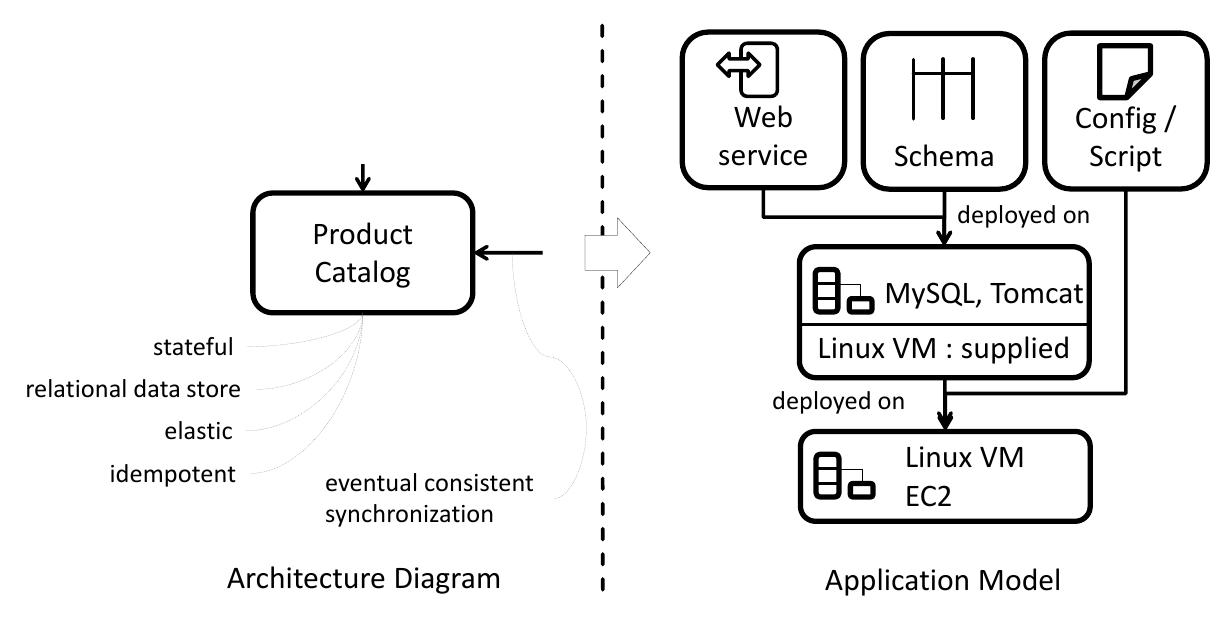
Figure 21. Concretization of the Product Catalog